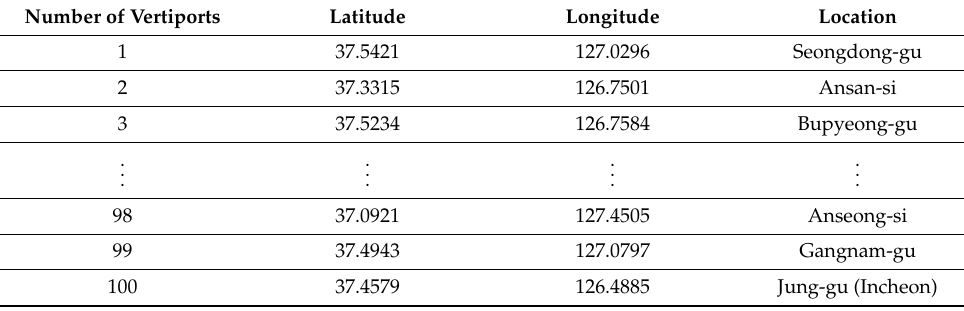
Table 6. Location of repositioned vertiports.